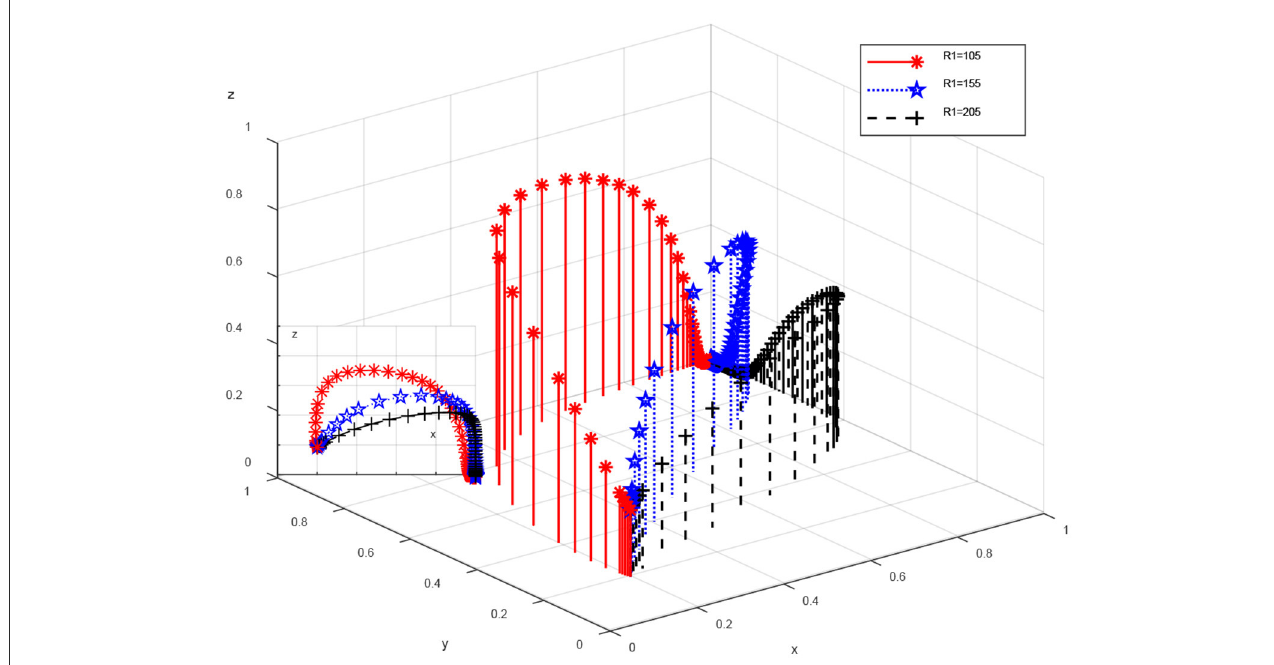
FIGURE5 Impact of changes in recycling industry earnings for choosing waste separation.